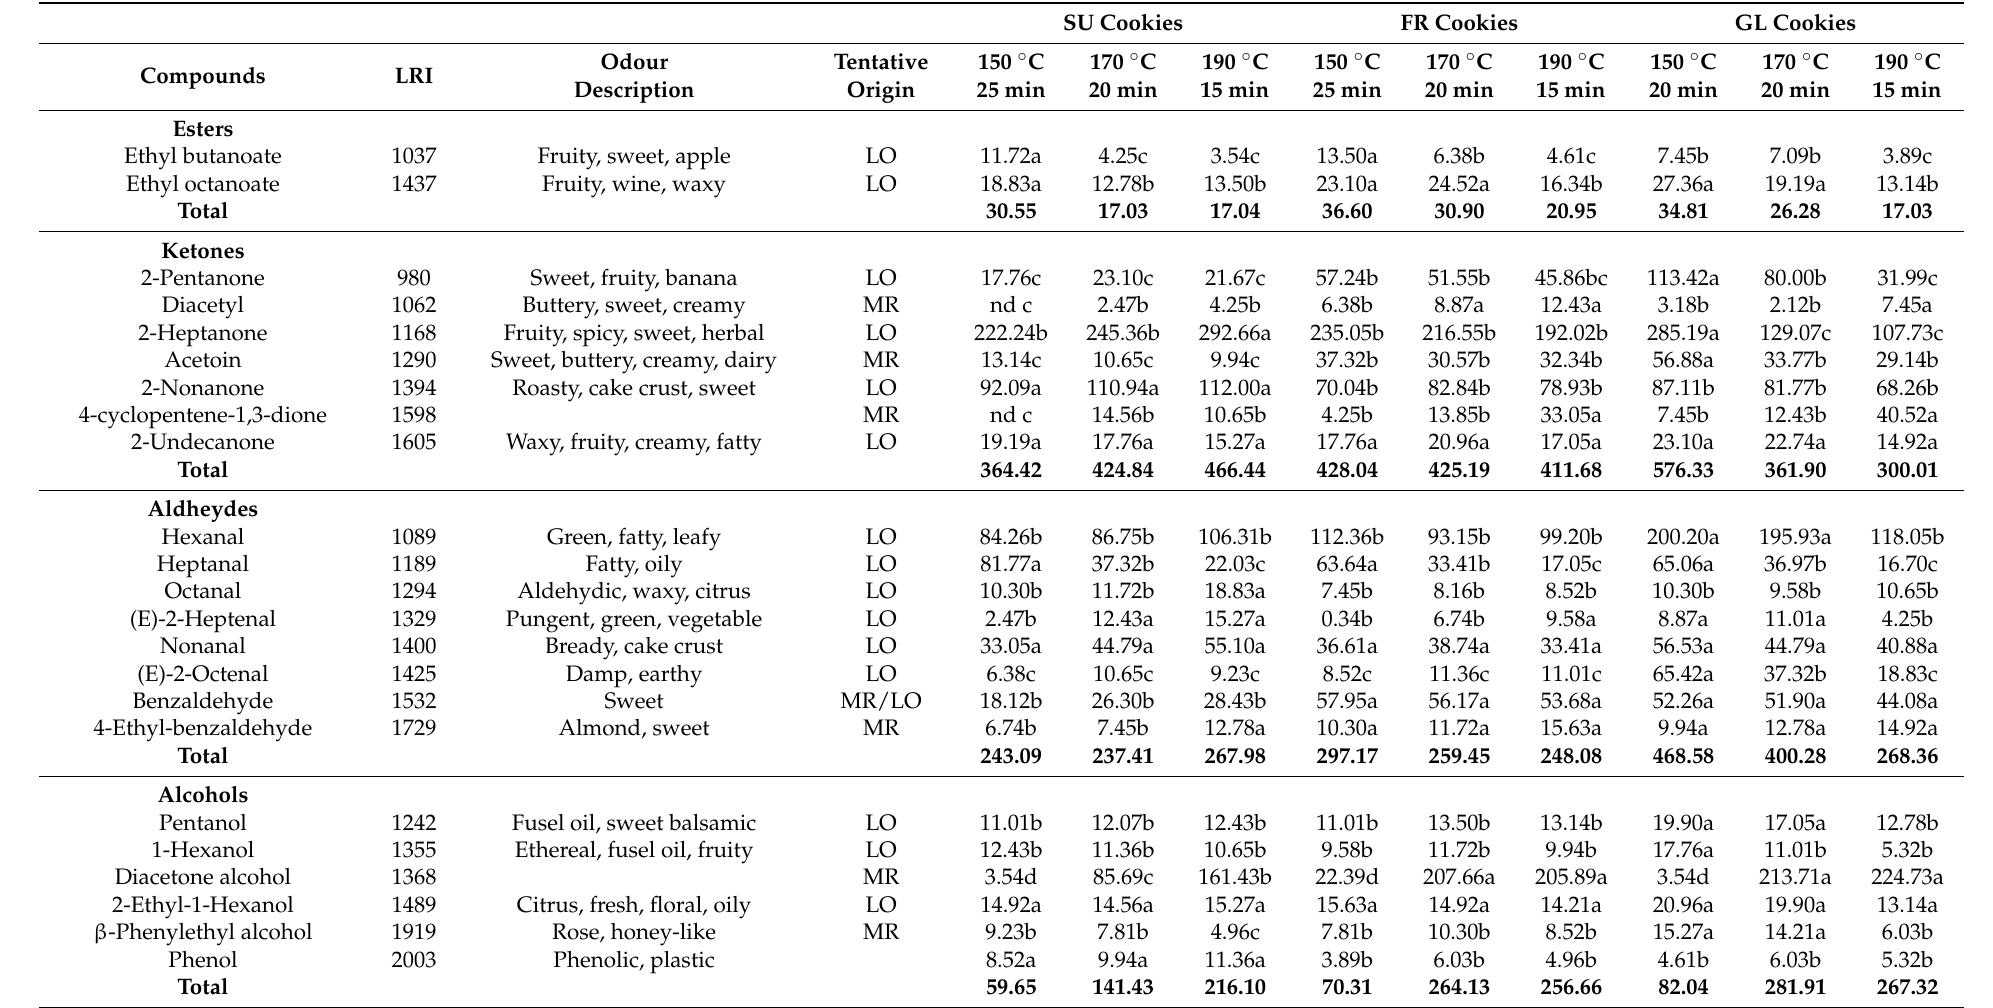
Table 3. Volatile aromatic compounds (ng/g) in cookies at the EOBT using different sugar